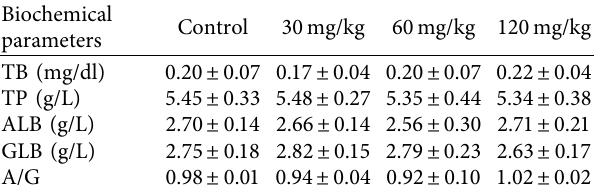
Figure 2: The effects of goose bone on serum hepatic marker enzymes. Results are expressed as mean ± SD ( n � 8). ∗ denotes level of significant difference when compared to the control group as determined using a one-way ANOVA followed by Dunnett’s multiple comparison tests.